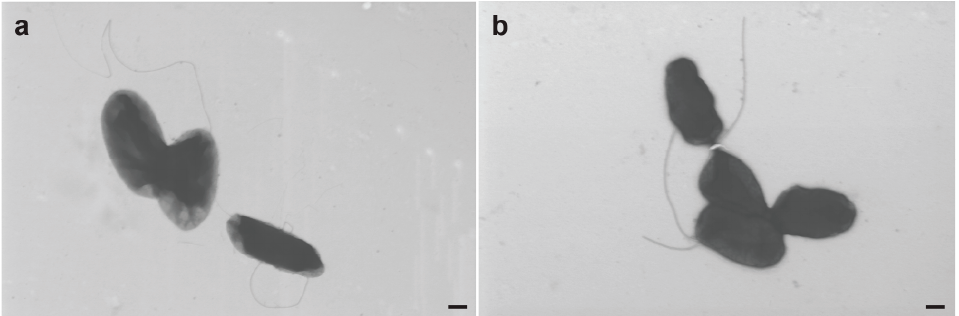
Figure 6. Electron microscopy pictures of R. meliponini D21B. ( a ) Cells were grown in a salt-free LB medium supplemented with 10% sucrose. ( b ) Cells were grown without sucrose in a salt-free LB medium. Scale bars indicate a length of 200 nm.